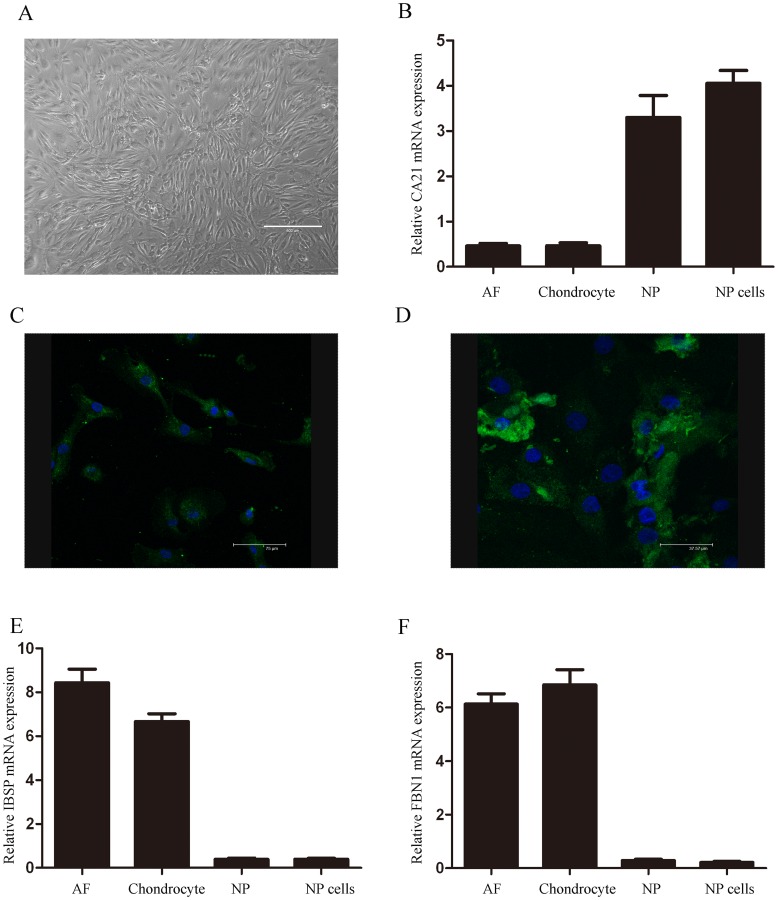
Morphology, immunofluorescence characterization and real-time quantitative PCR validation of primary cultured human NP cells.(A) Phase-contrast photomicrograph of primary NP cells cultured in vitro for about 1 week, just before reaching complete confluence. Original magnification, ×40. (B) Real-time RT-PCR analysis of novel NP cell marker gene CA12 in NP cells, chondrocytes, NP and AF. Real-time RT-PCR analysis was performed in triplicate and the expression levels of CA12 mRNAs were normalized to GAPDH mRNAs. Error bars represent standard deviration. (C) Fluorescence microscopy images showing collagenase type II were observed in NP cells. Nuclei were stained with DAPI, shown in blue. Images were acquired using laser scanning confocal microscopy under a 40× objective. (D) Fluorescence microscopy images showing cytokeratin 19 were observed in NP cells. Nuclei were stained with DAPI, shown in blue. Images were acquired using laser scanning confocal microscopy under a 40× objective. Real-time RT-PCR analysis of novel negative NP cell marker gene IBSP (E) and FBN1 (F) in NP cells, chondrocytes, NP and AF. Real-time RT-PCR analysis was performed in triplicate and the expression levels of IBSP and FBN1 mRNAs were normalized to GAPDH mRNAs.